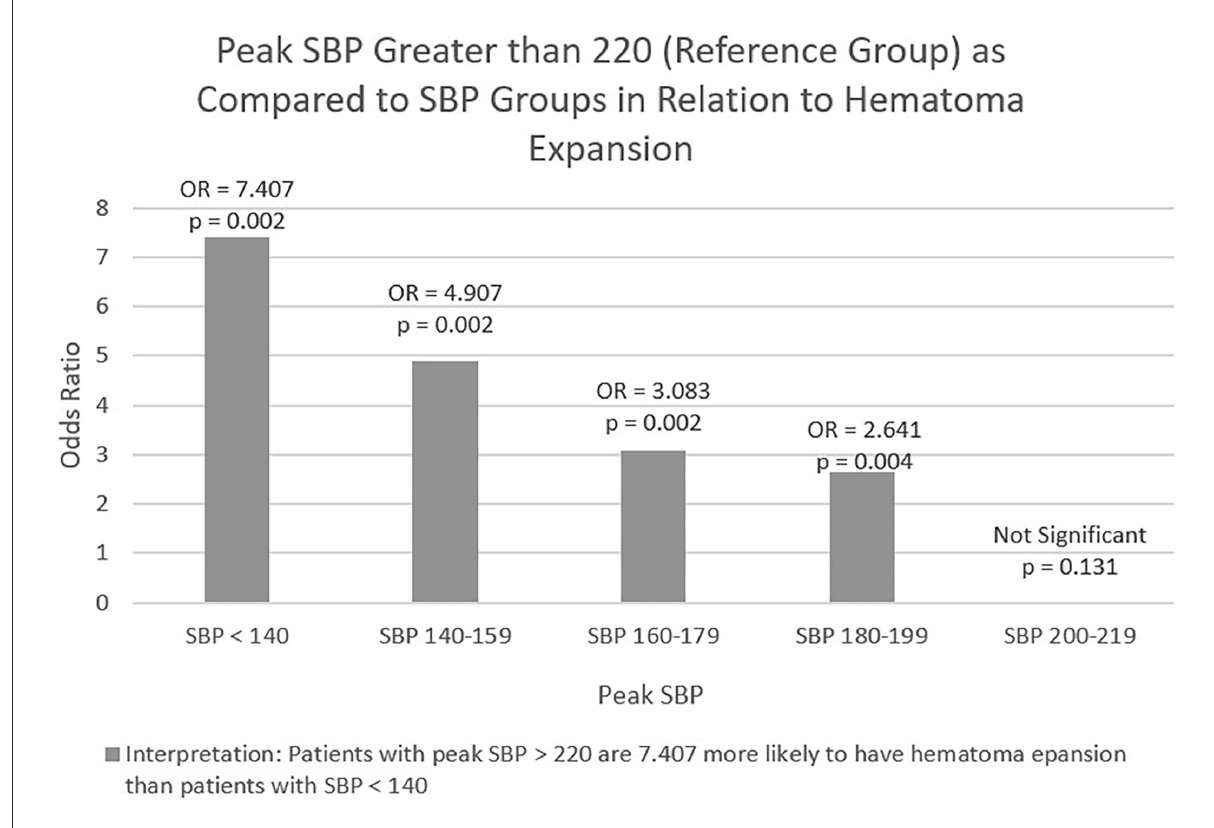
FIGURE3 Logistic regression of peak SBP and hematoma